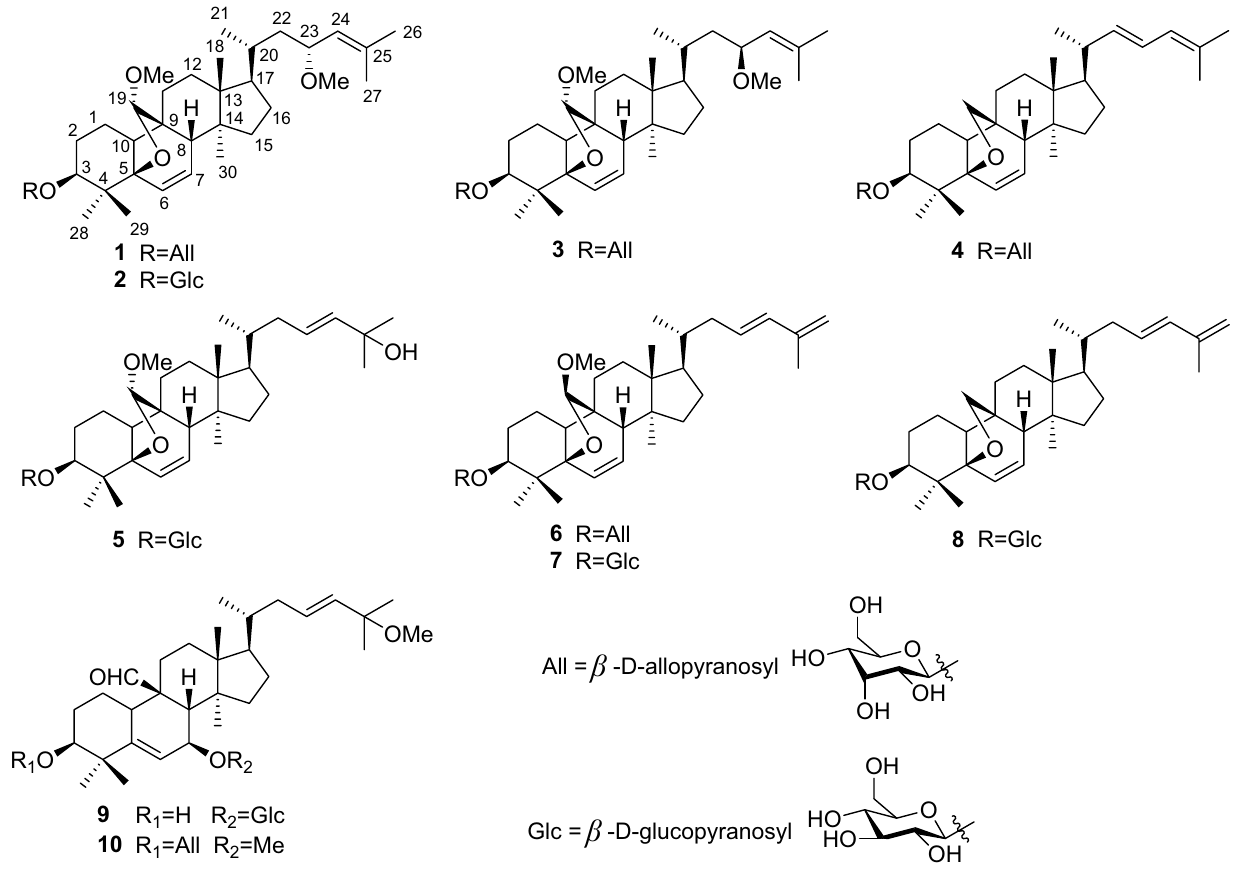
Fig. 1 Chemical structures of compounds 1–10 from M.